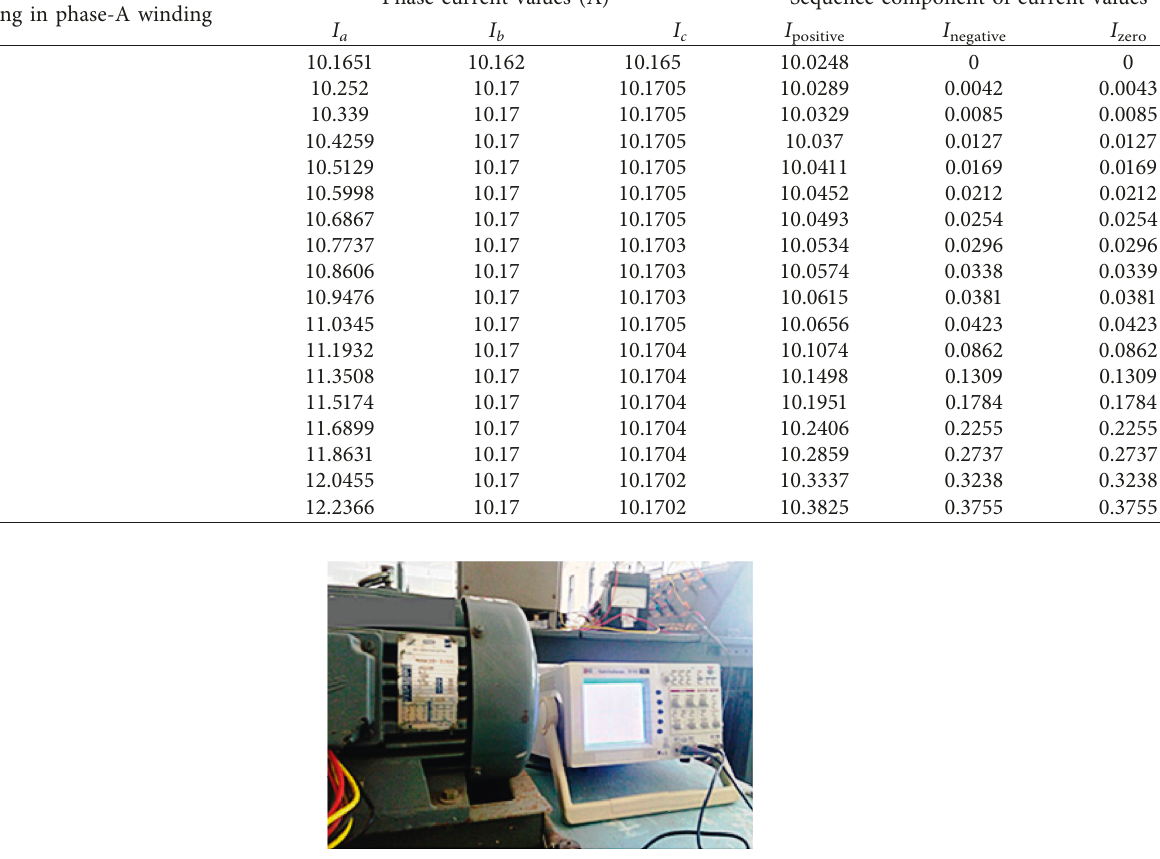
Table 1: Magnitude of phase currents and sequence components of phase currents.